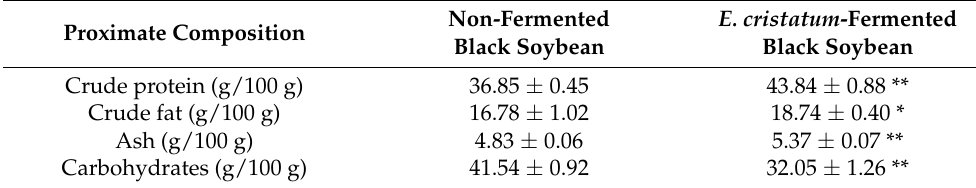
Table 1. Proximate composition of E. cristatum -fermented and non-fermented black